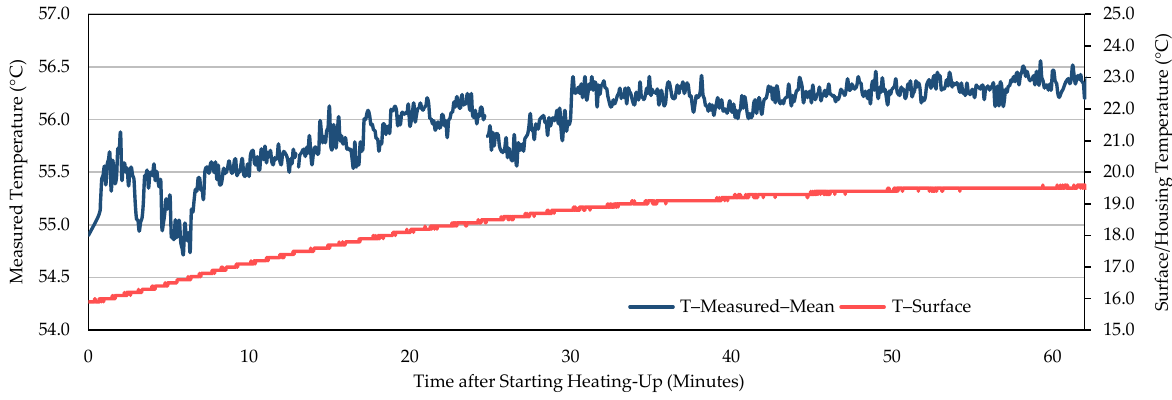
Figure 5. The measured average temperature of the blackbody (55 °C) area, as recorded by WIRIS 2nd GEN over 2 h after activation. The STD of the measured temperature is also included. In this session, the automatic NUCs were enabled every 30 min. This figure is used as a comparison with Figure 4 to visualize the influence of NUC frequency under the same experimental conditions. Due to a malfunction, no data was recorded between 17 and 28 min.